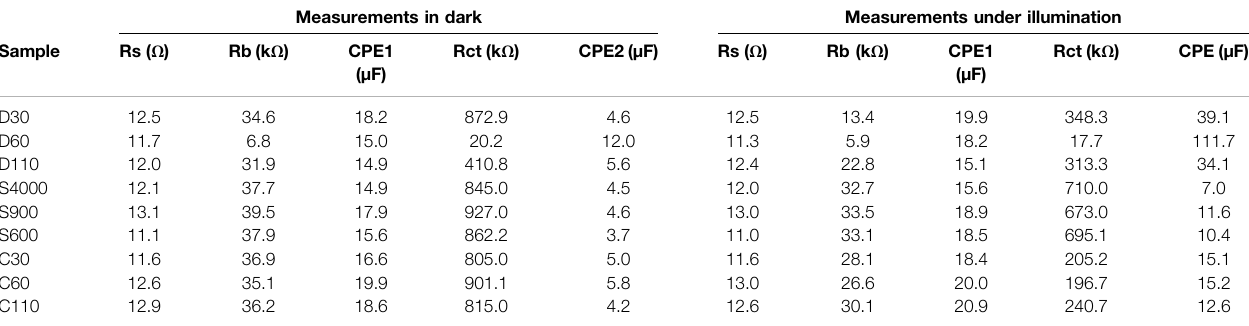
1.23 V vs RHE observed for the fi lms ( Figure 6A ) compared to the other samples.